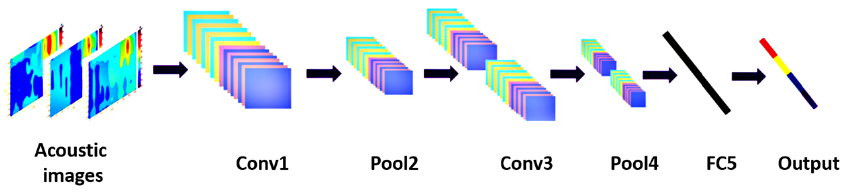
Figure 16. Transfer the acoustic signal to image (CNN model) [69].